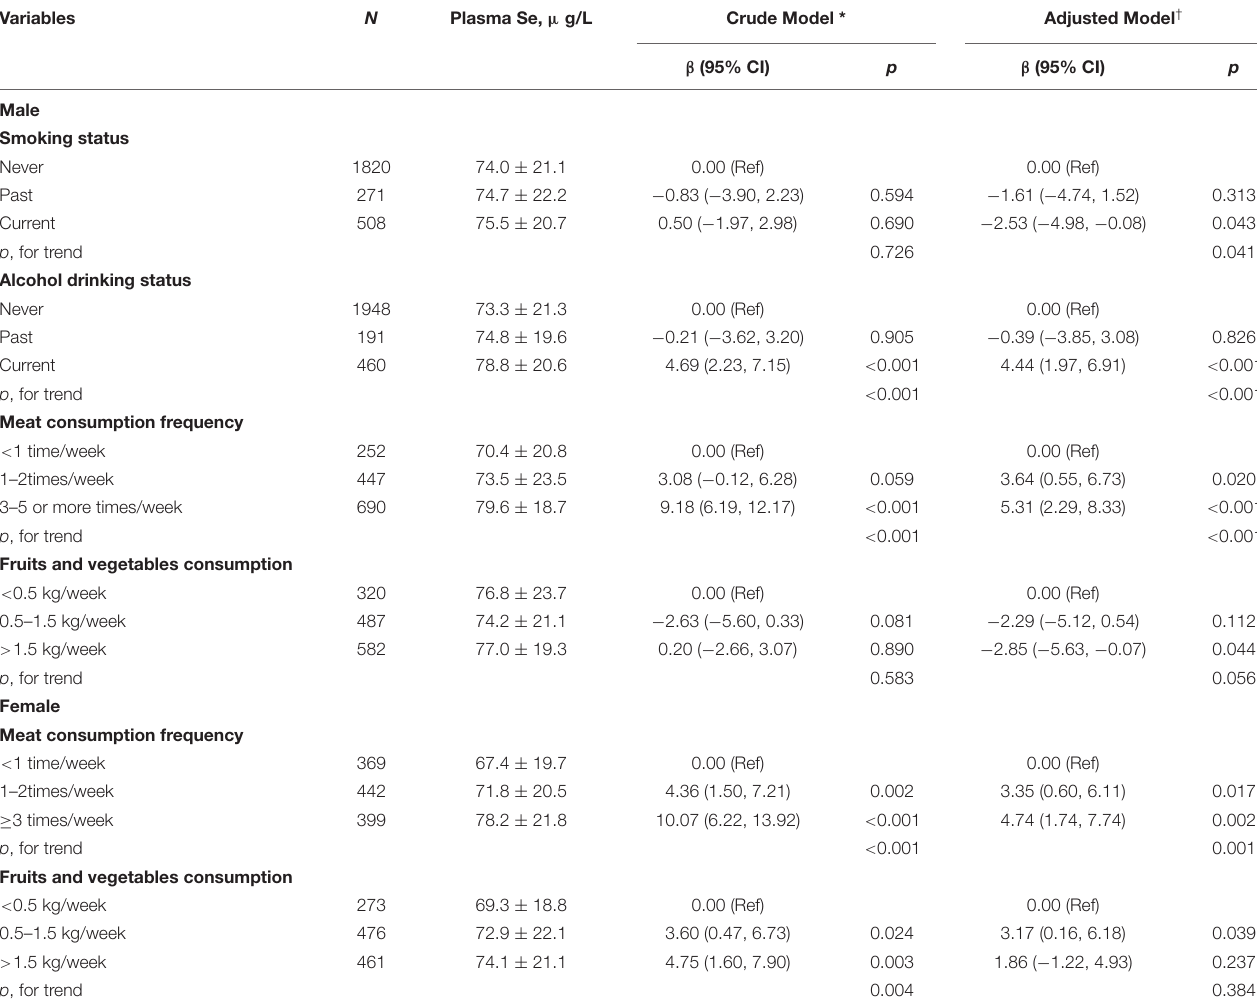
TABLE 3 | The β and 95% CI of plasma Se concentrations by lifestyle and dietary habits in Chinese middle-aged and elderly adults with hypertension stratified by sex 1 . Variables N Plasma Se, µ